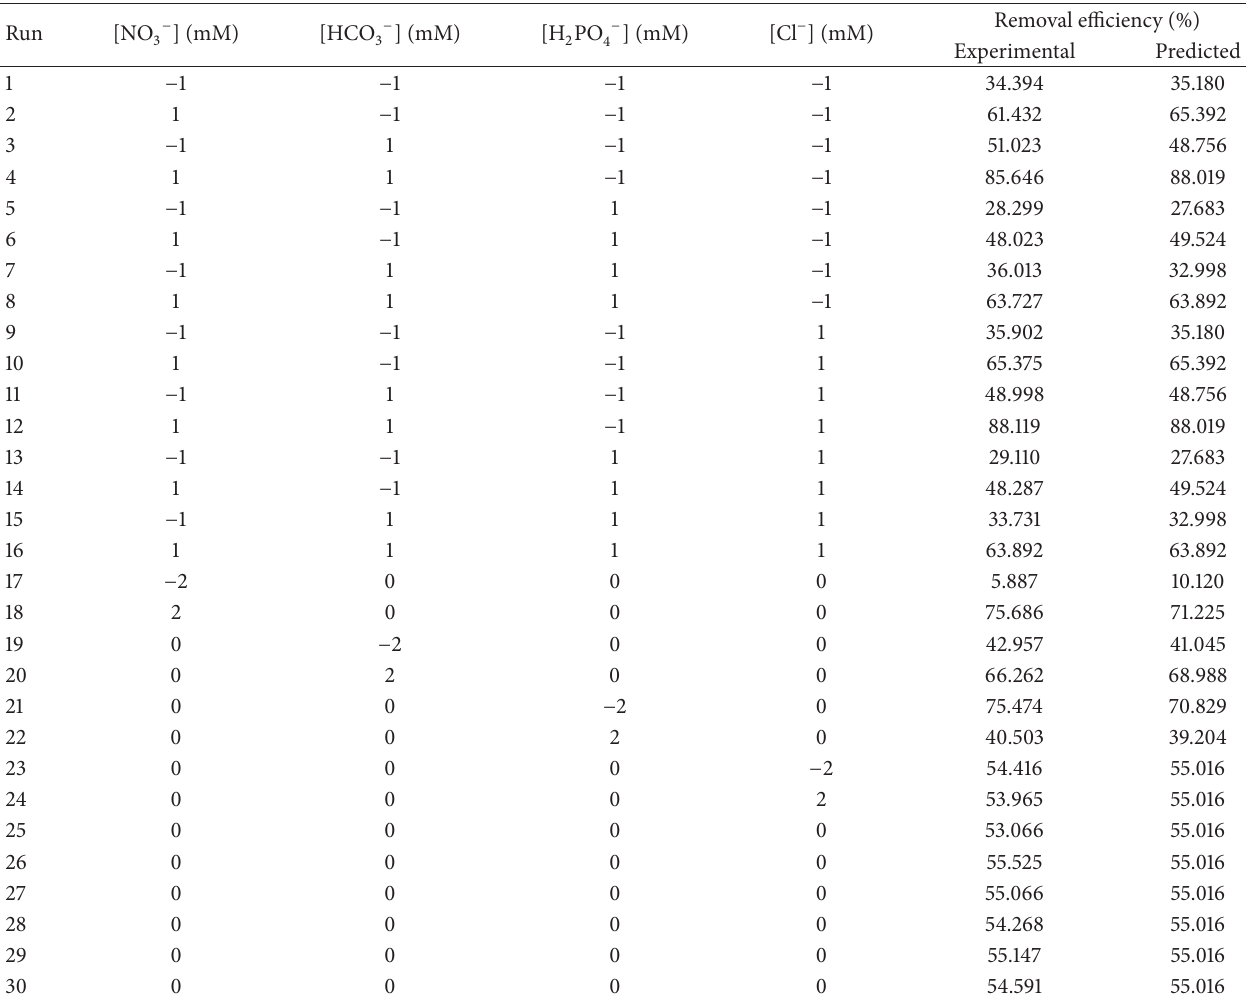
Table 4: The four-factor central composite design matrix and the value of the response function ( 𝑅